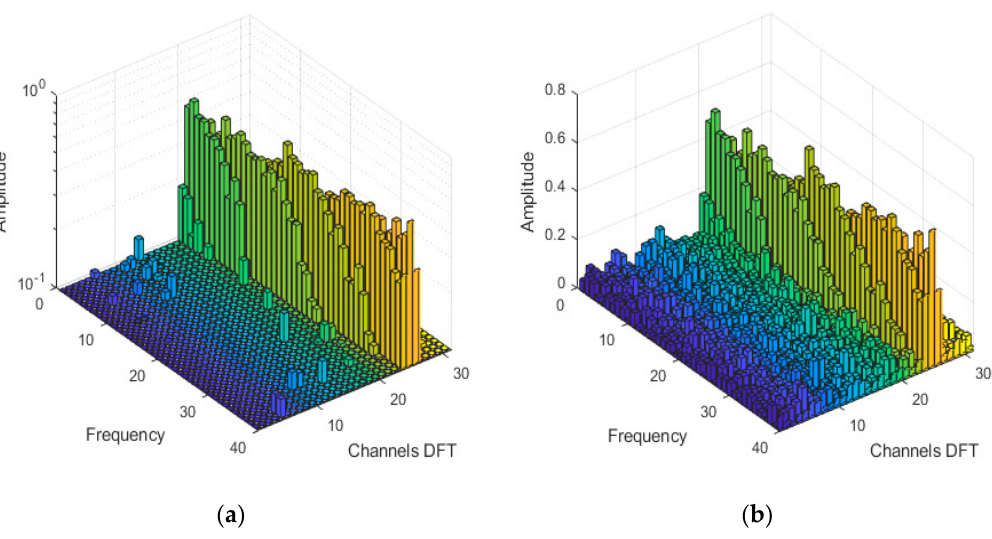
Figure 9. The magnitude response of the DFT channels using the Hanning window transform: ( a ) Logarithmic scale; ( b ) linear scale.